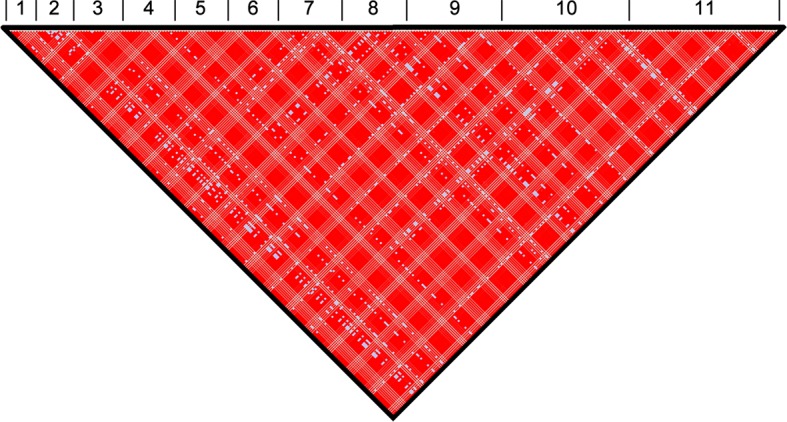
Genome-wide linkage disequilibrium (LD) among T.b. gambiense Group 1 parasites.Normalised LD was assessed across all eleven chromosomes. The position of each SNP used in this analysis is illustrated. The black triangle illustrates the single linkage group identified in the analysis, which spans the entire genome. Numbers 1–11 represent the 11 chromosomes. Red (D'>1, LOD≥2), Pink (D'<1, LOD≥2), Blue (D'=1, LOD<2) and White (D'<1, LOD<2).